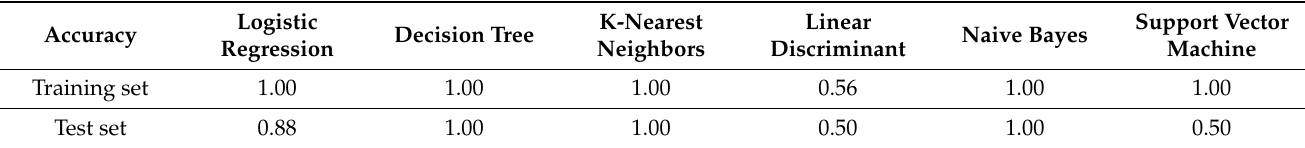
Table 3. Accuracy values for different machine learning algorithms with the combined linear regression approach applied on the isotropic materials’ results.